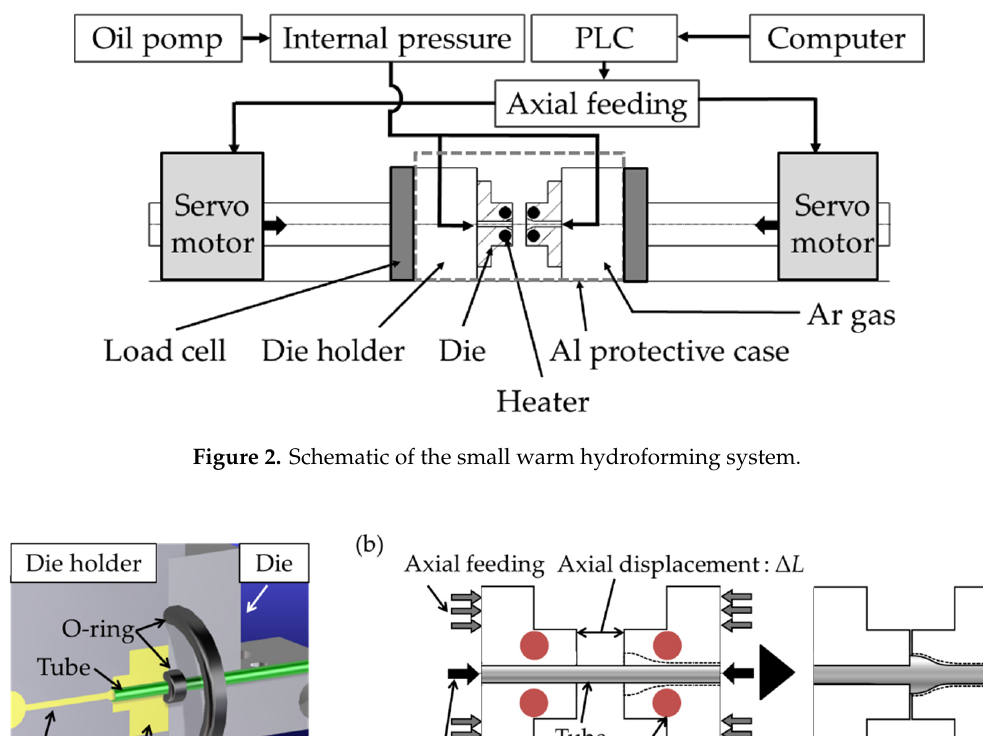
Figure 3. Geometry diagram of the die for the warm tube hydroforming (THF): ( a ) sealing mechanism; ( b ) loading mechanisms of the axial feeding and internal oil pressure in the tube for the experiment.